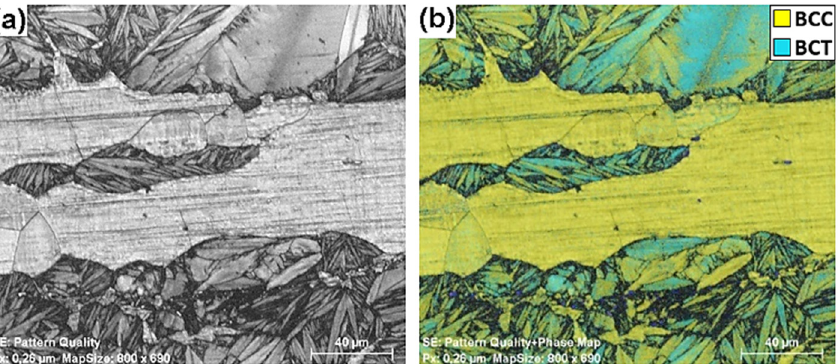
Figure 6. EBSD/SEM sample analysis obtained from the dilatometry test under 50 °C/s cooling rate: ( a ) pattern quality; ( b ) phase map (BCC = body-centered cubic; BCT = body-centered tetragonal).